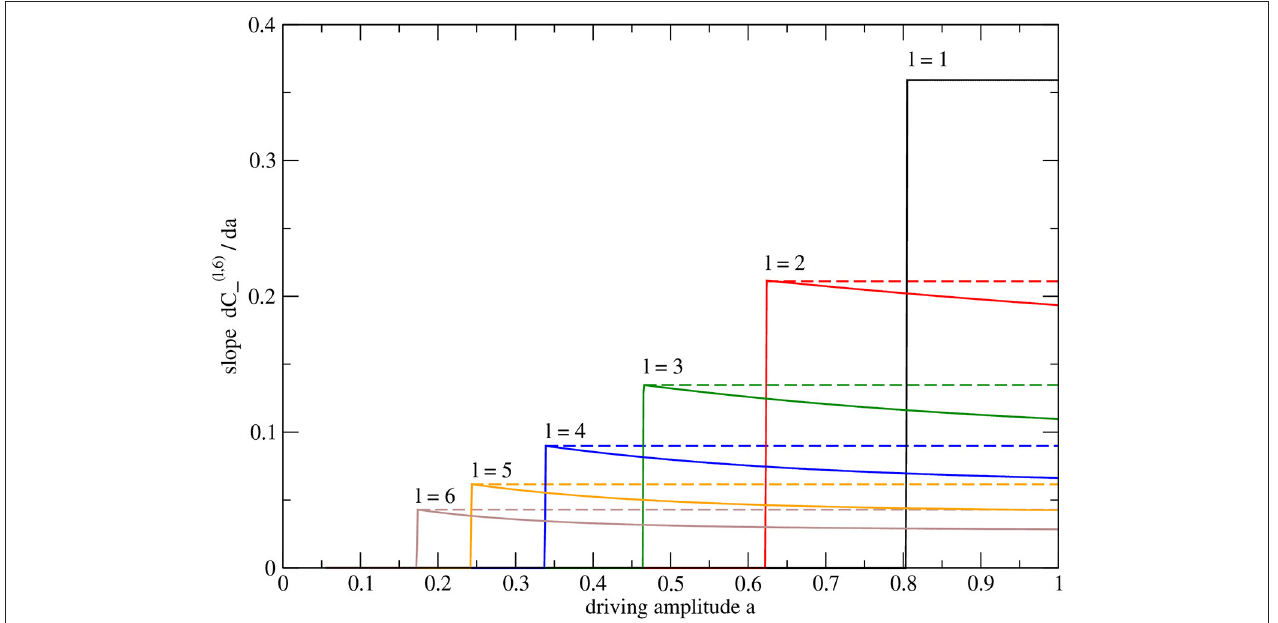
FIGURE 5 | Slopes of conductances of cross edges in the system with height H numerically determined derivatives of the data plotted in Figure 3F . For each curve, the maximum value is indicated by an extra vertical dashed line. Note that the derivative is piecewise constant only for the cross edge closest to the root. The other conductances exhibit maximal slope only at the critical